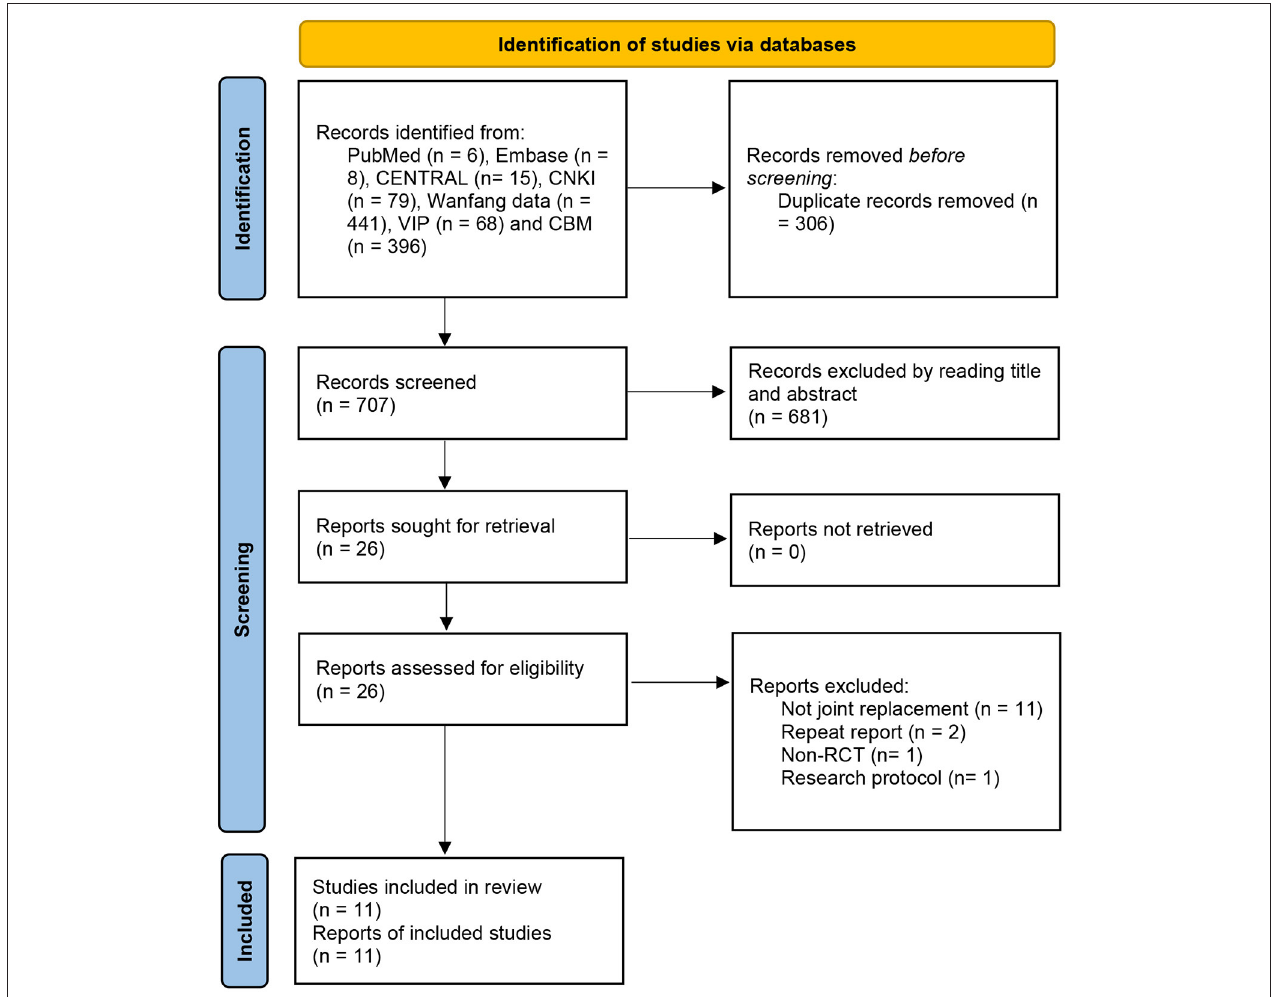
FIGURE 1 | Flow diagram of literature